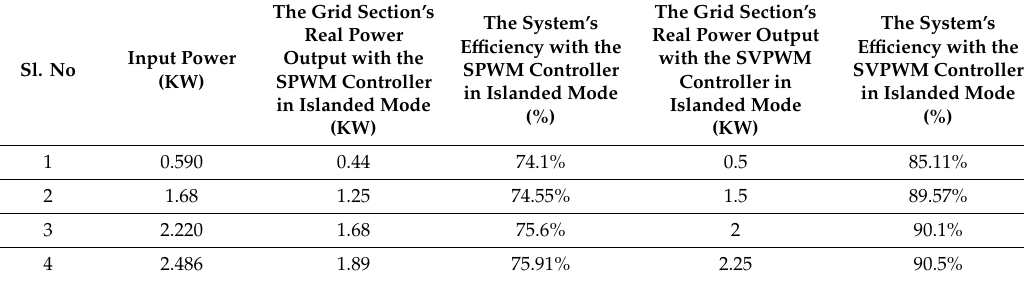
Table 4. The system’s e ffi ciency with the SPWM and SVPWM controllers.